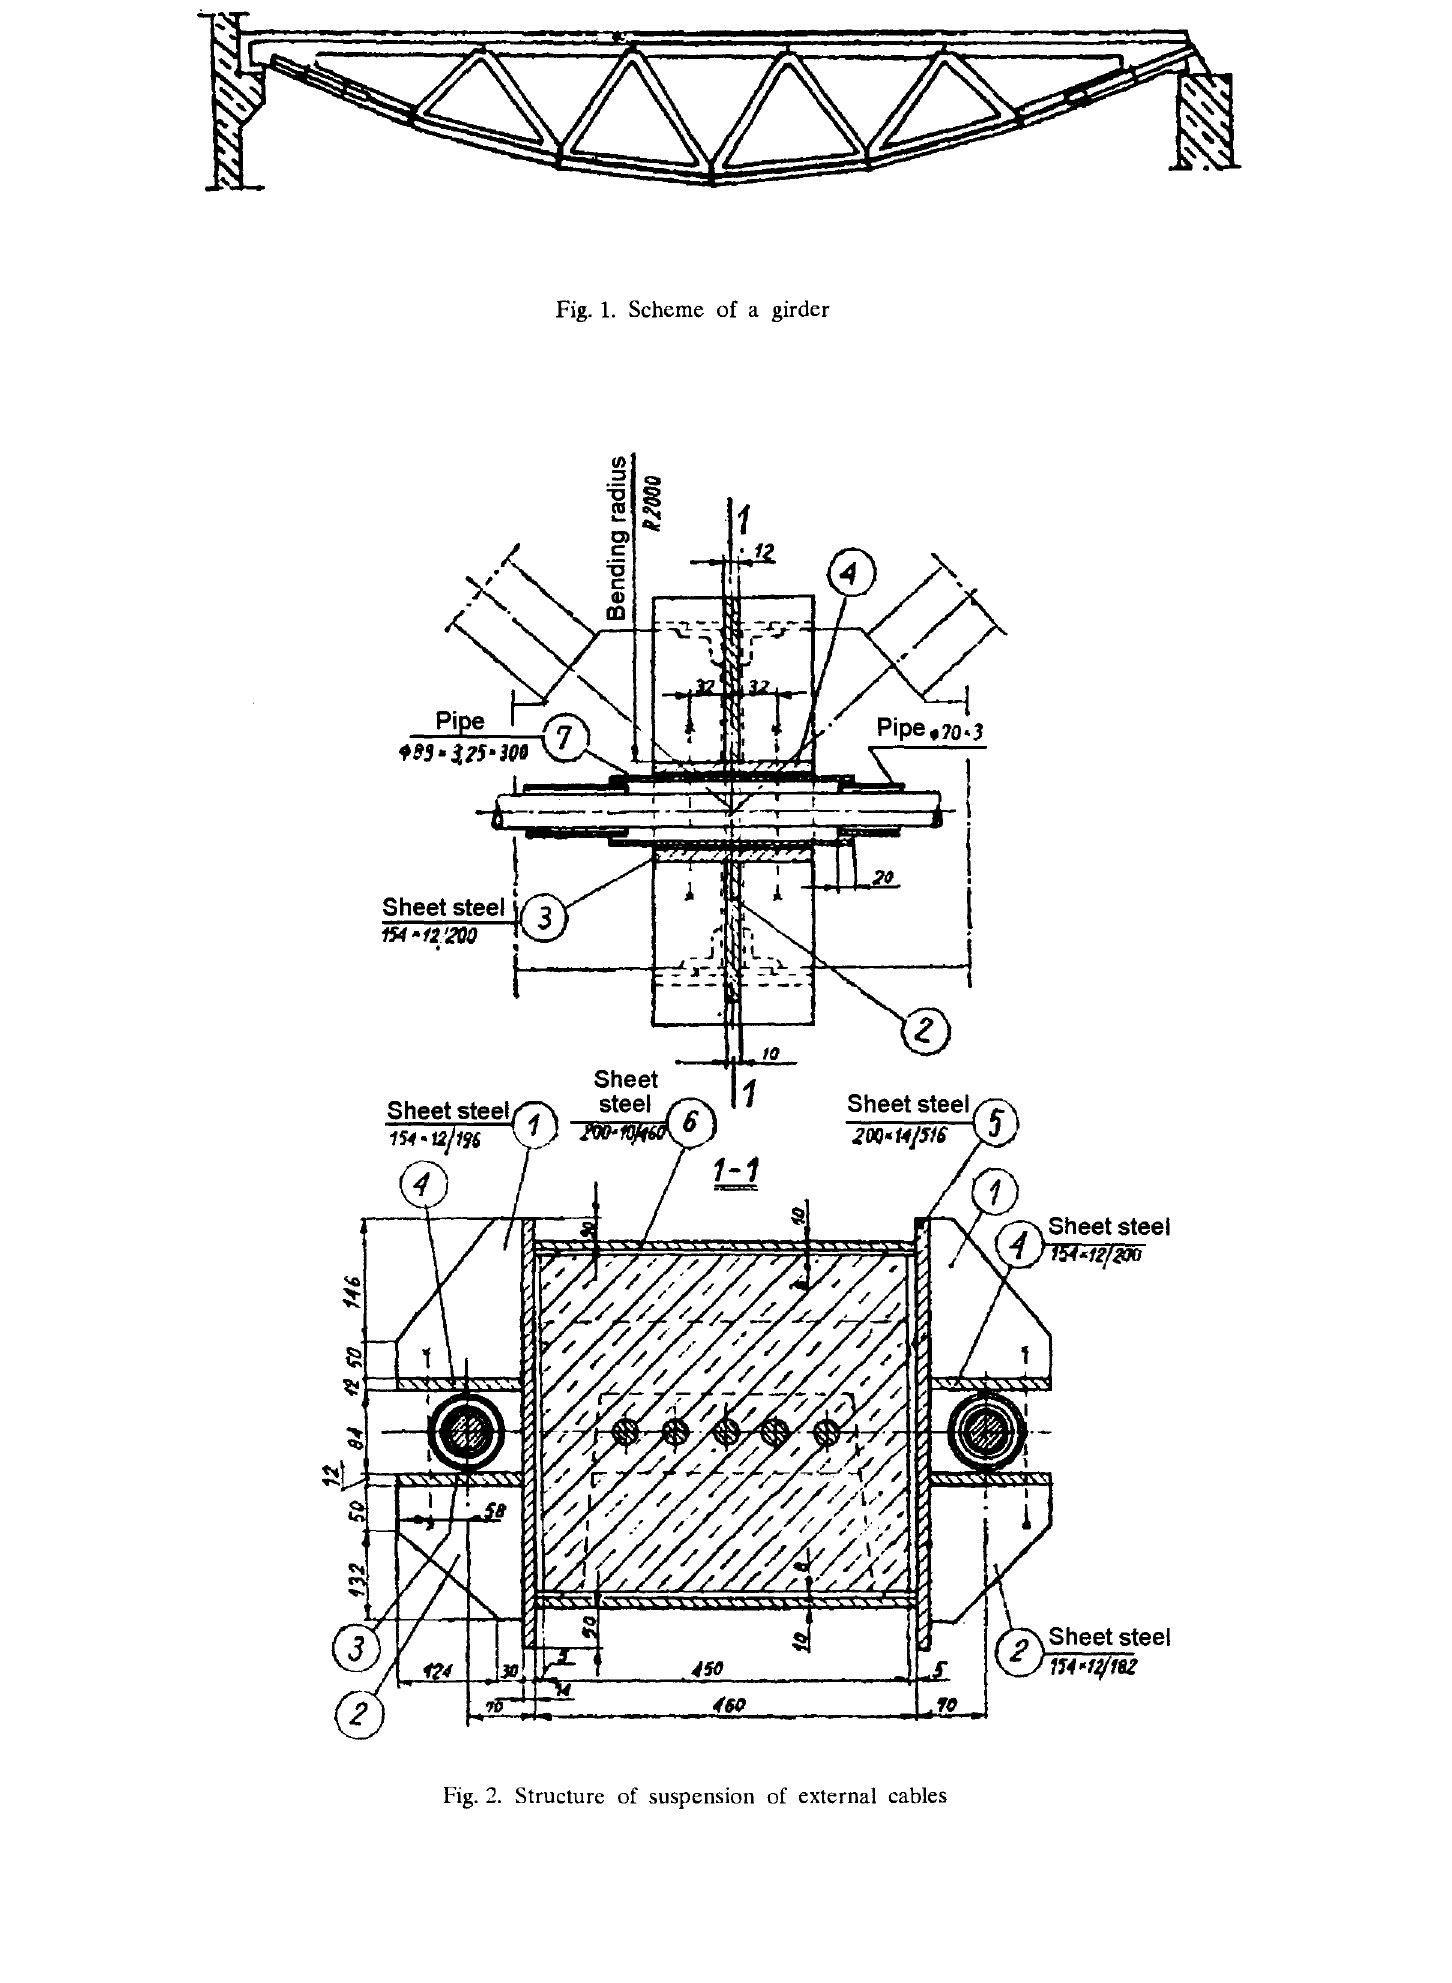
Fig. 2. Structure of suspension of external